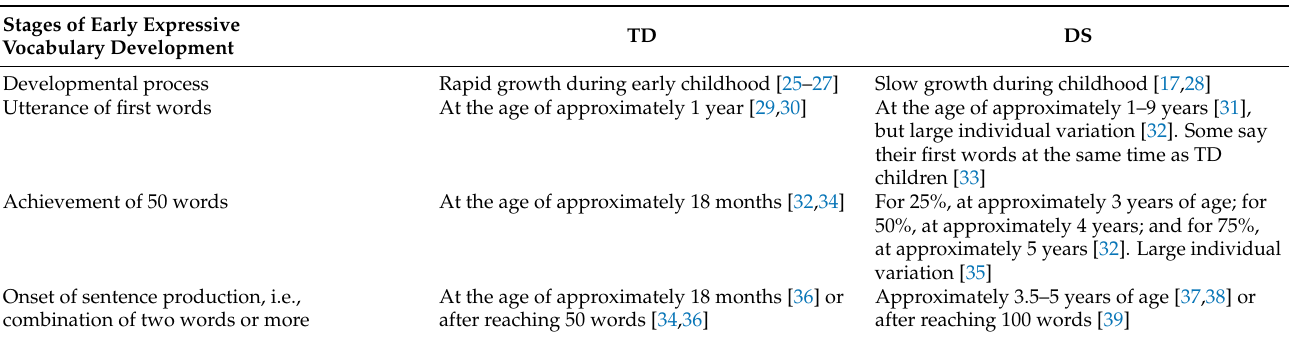
Table 1. Overview of the main stages of expressive vocabulary development in young typically developing children and children with Down